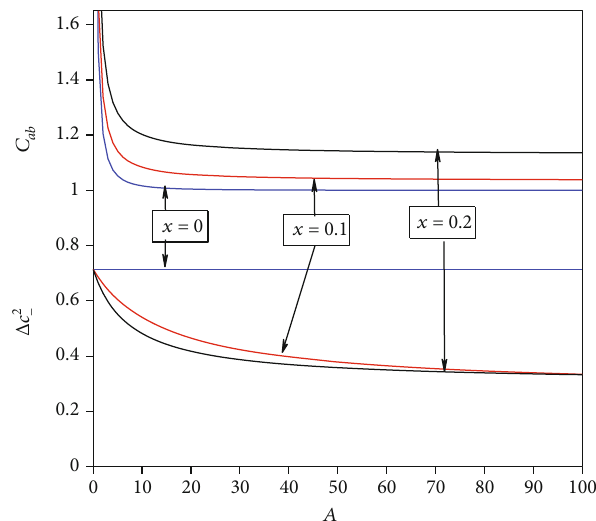
Figure 15: The steady state photon number correlation function of the two-mode cavity radiation versus x for κ = 0 : 5 , ε = 0 : 06 , C ab and di ff erent values of x